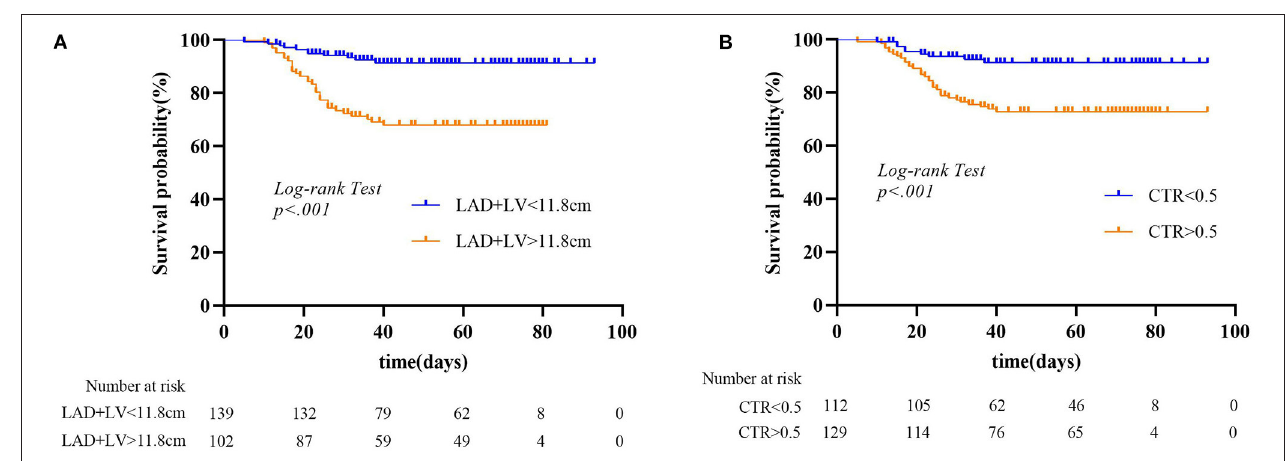
FIGURE 5 | (A,B) Kaplan–Meier curves for chest CT parameters and all-cause mortality endpoint. LAD, anteroposterior diameter of the left atrium; LV, length of the left ventricle; CTR, cardiothoracic ratio.